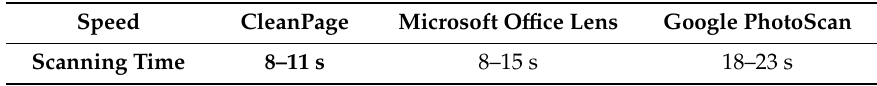
Table 4. Comparison of scanning times over several trials. Time was measured from the first step of the process to the appearance of the output image